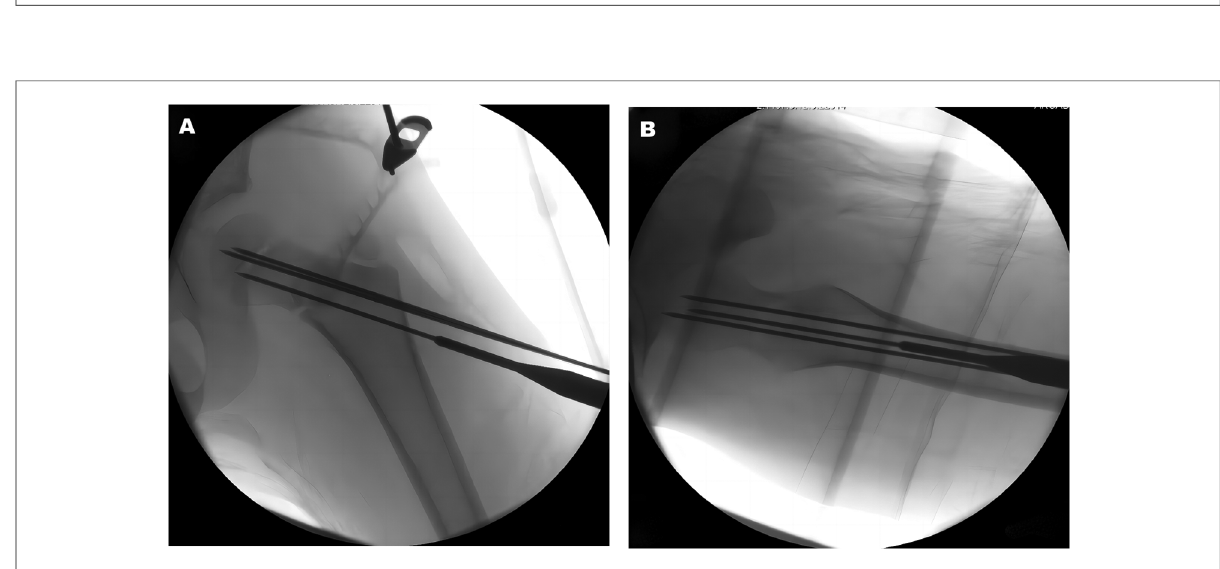
FIGURE 3 Three guide pins were drilled into the bone passage in sequence through the sleeve under fl uoroscopy monitoring as shown in the AP ( A ) and lateral ( B )